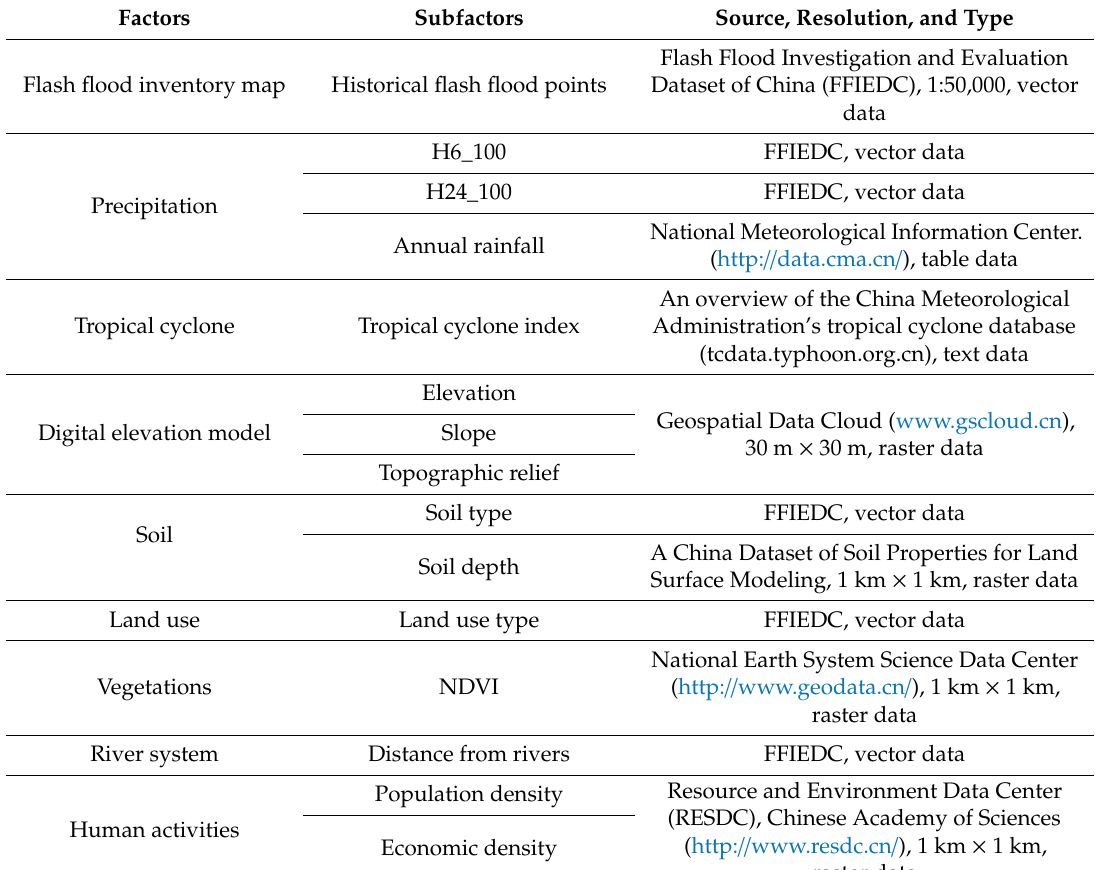
Table 1. Sources and types of raw